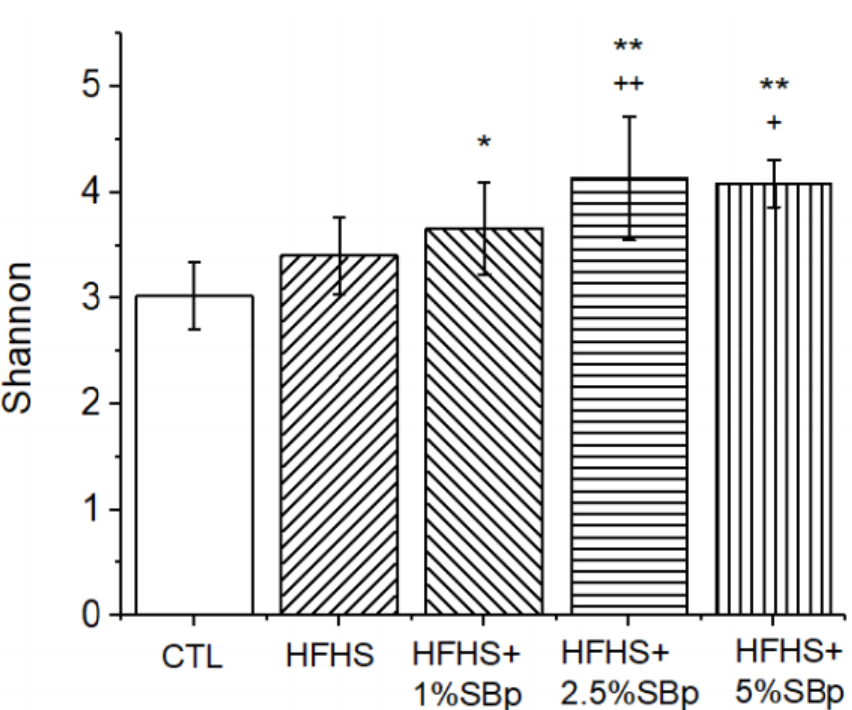
Figure 4. Effect of HFHS diet supplemented with SBp on α -diversity of gut microbiota in mice. Male C57 BL/J6 mice fed with low fat diet (control or CTL), HFHS diets or HFHS diet supplemented with 1%, 2.5% or 5% SBp for 11 weeks. Fecal samples were collected from individually caged mice at in the final weeks after of the dietary intervention. Shannon indices were expressed in mean ( n = 8). *,**: p < 0.05 or 0.01 vs. CTL; +, ++: p < 0.05 or 0.01 vs. HFHS diet. PCA analysi s demonstrated that β -diversity in (control) mice fed a low fat diet com- pletely separated from that of mice fed HFHS diet. β -Diversity in mice fed HFHS diet diet alone; however, in mice fed HFHS diet supplemented with 1% SBp, this partially overlapped with that in mice fed HFHS diet alone (Figure 5).